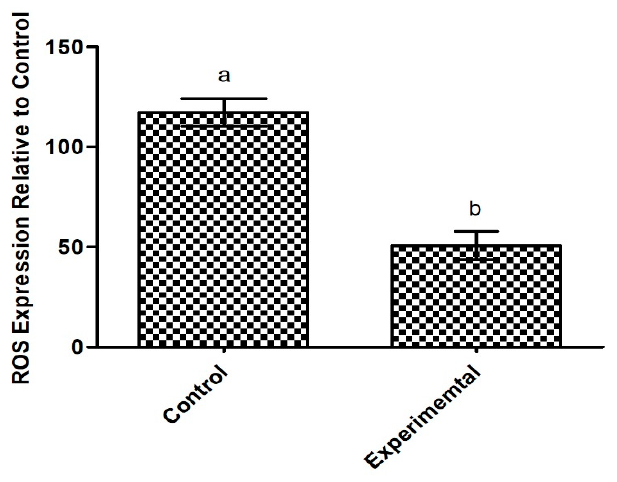
Figure 6. The expression of reactive oxygen species in HT-29 cells treated with Apilactobacillus waqarii EPS and control. The values of data sets ( n = 5) denoted by different alphabet are significantly different ( p < 0.05).